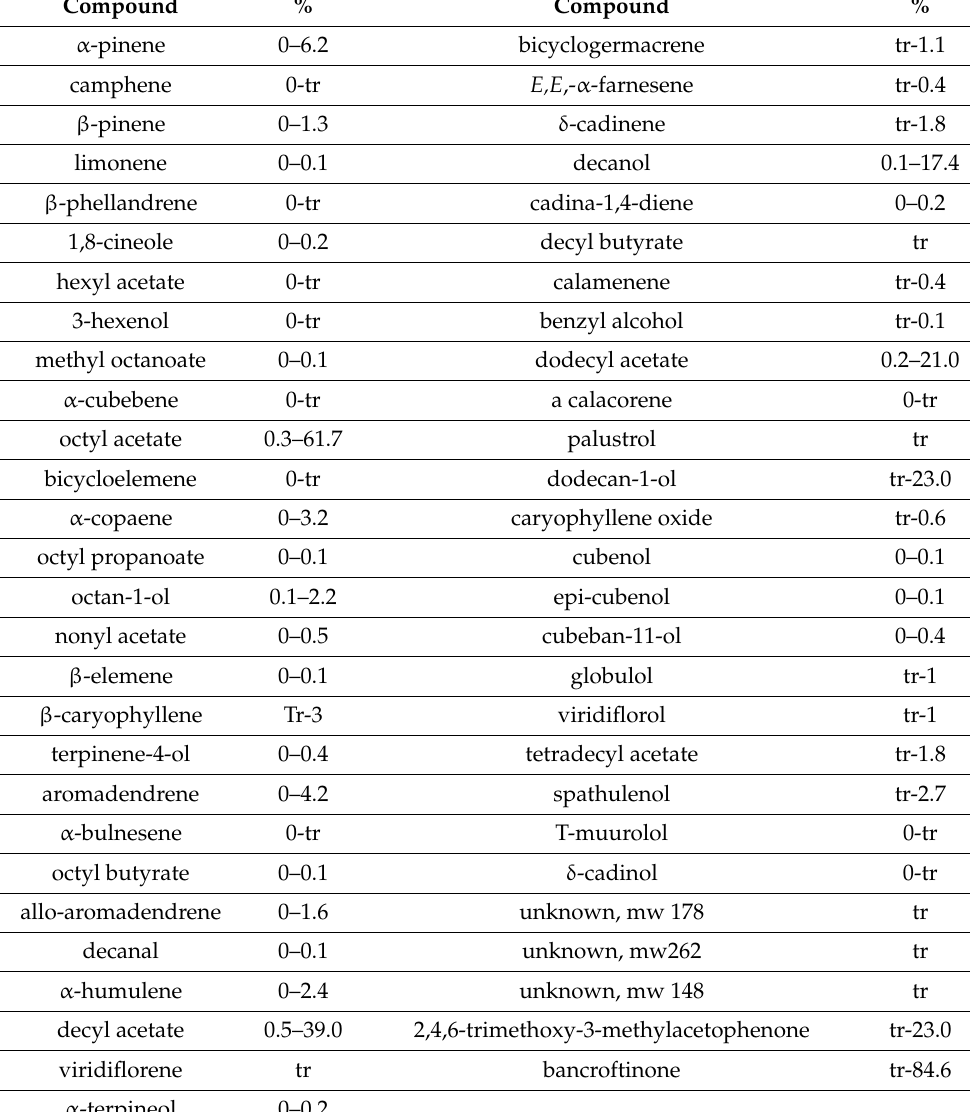
Table 4. Compounds identified in the leaf oil of Backhousia bancroftii